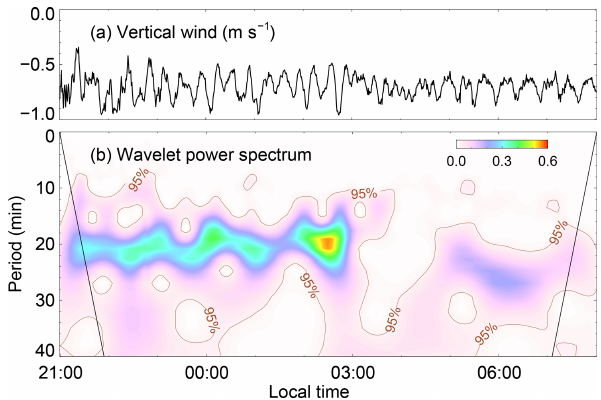
Figure 3. (a) Mean vertical wind between 600 and 1000m. (b) Cor- responding wavelet power spectrum of the vertical wind in (a) . The brown contours indicate a significance level of 95%. The black solid lines represent the cone of